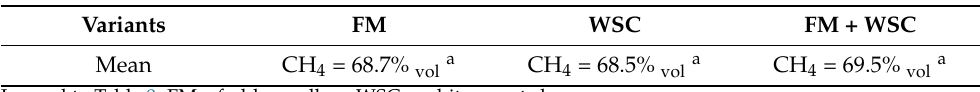
Legend to Table 8: FM—fodder mallow, WSC—white sweet